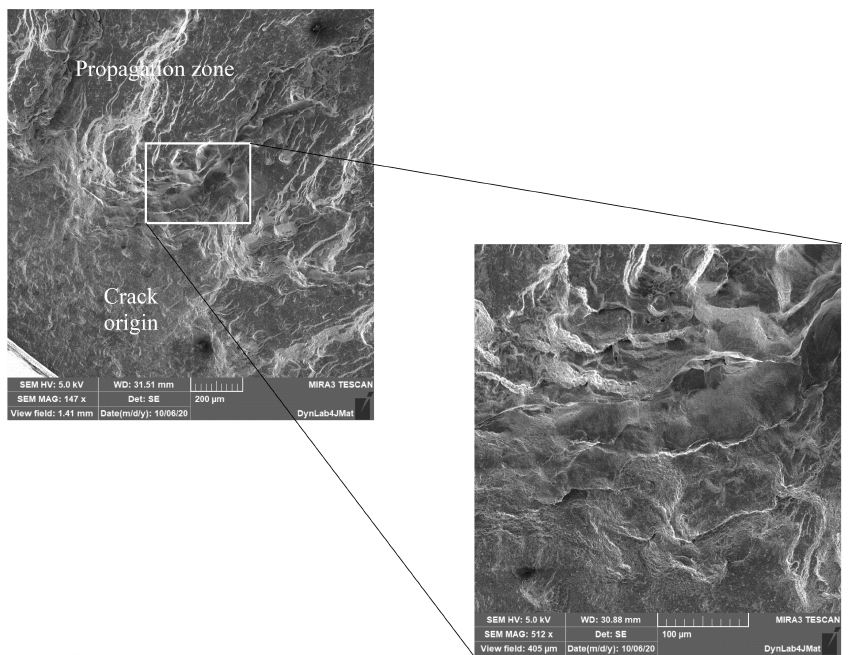
Figure 9. SEM images details of the propagation zone and striation marks of the specimen of 12 mm in